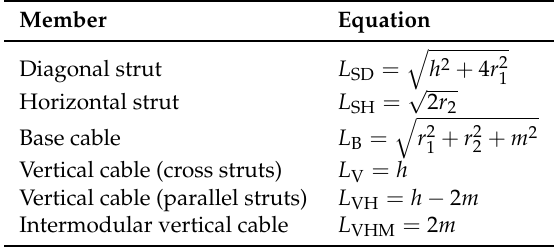
Table 5. Octahedron column—functions of the member